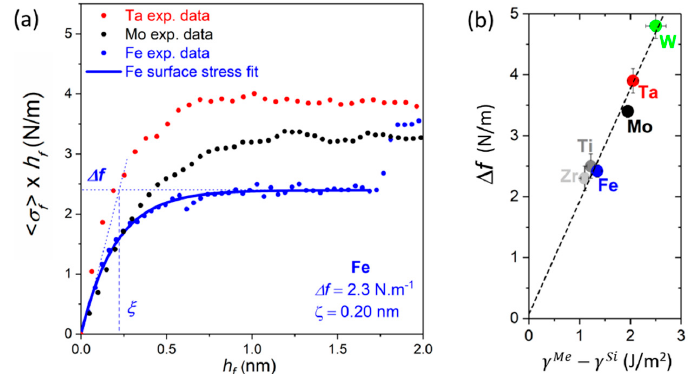
Figure 11. ( a ) Enlarged view of the stress-thickness evolution at the Me/a-Si interface during growth of Fe, Mo, and Ta on a-Si. An analytical model, Equation (9), is used to fit experimental data (see solid